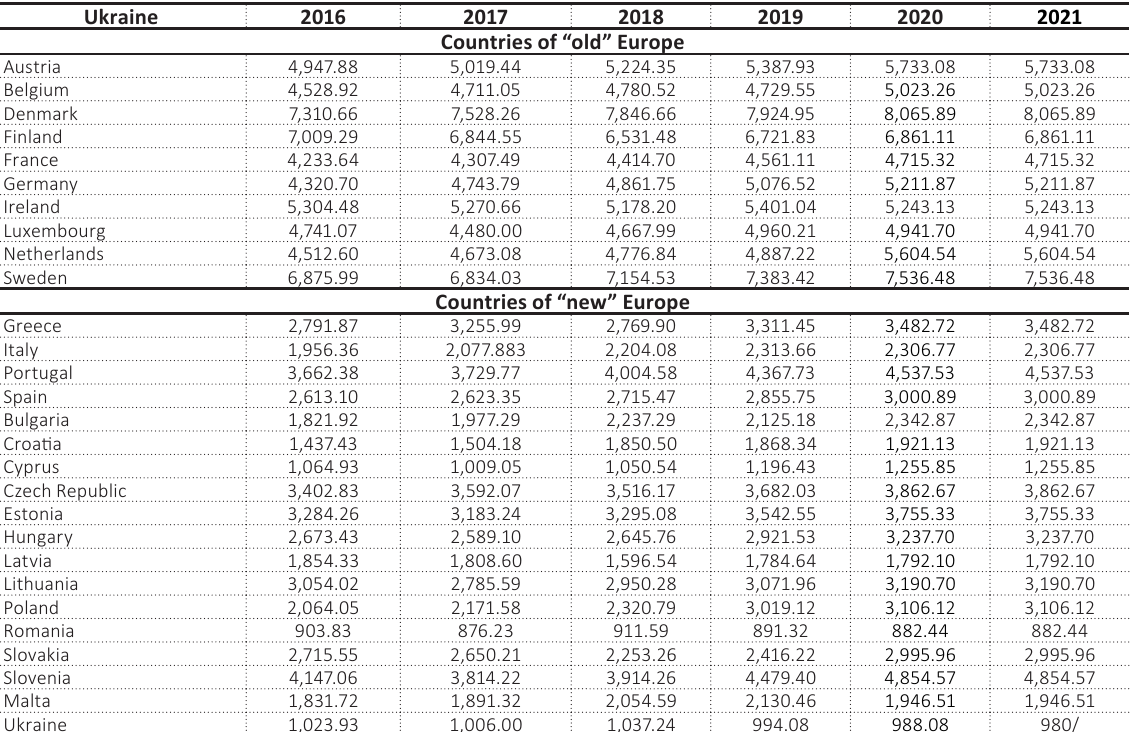
Table C1. Researchers in the R&D sector, per million (Х3)